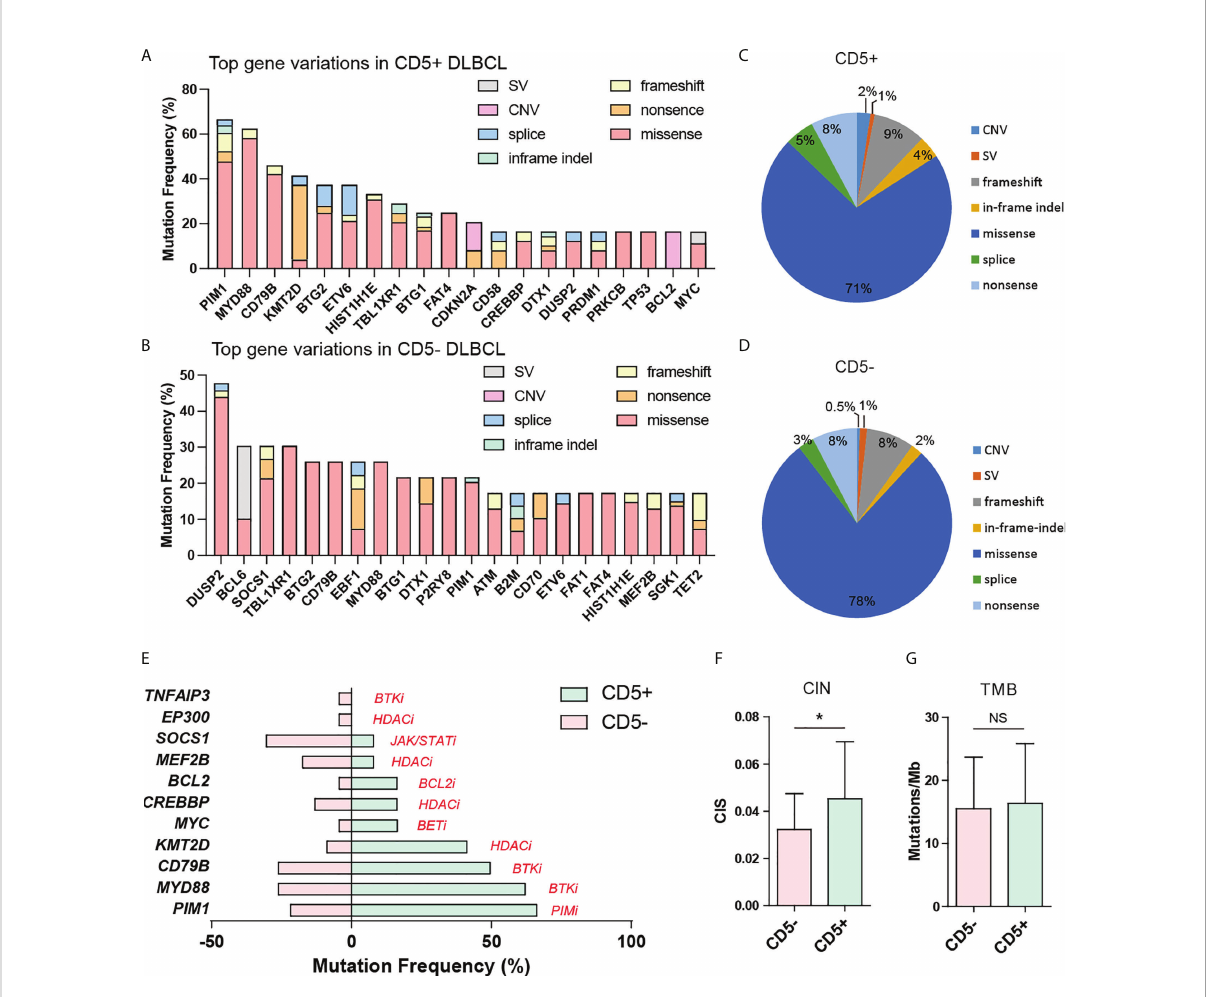
FIGURE 2 DNA-based targeted sequencing revealed the genetic disparity between CD5+ and CD5- DLBCL. The most enriched gene variations in (A) CD5+ DLBCL and (B) CD5- DLBCL showed remarkable differences. The composition of genetic variation types of (C) CD5+ DLBCL and (D) CD5- DLBCL. (E) Mutations with available inhibitors were more frequently shown in CD5+ DLBCL. (F, G) CD5+ DLBCL showed elevated CIN but similar TMB compared with CD5- DLBCL. SV, structural variation; CNV, copy number variation; CIN, chromosomal instability; TMB, tumor mutational burden; NS, not signi fi